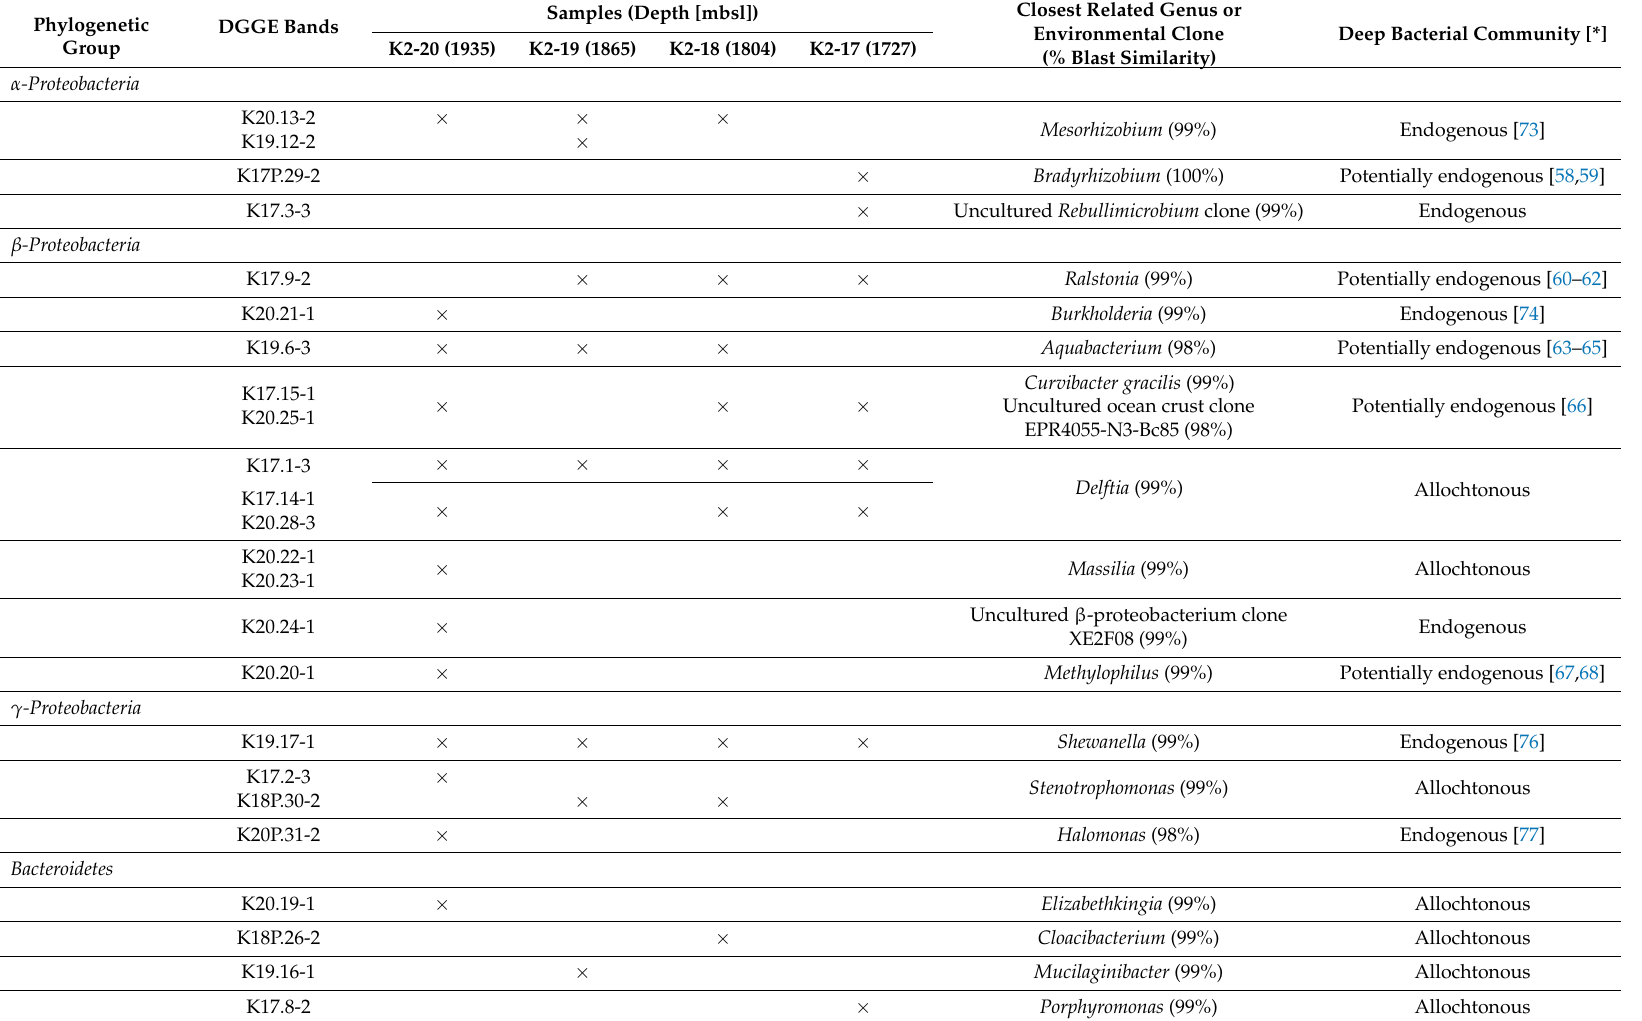
Table 4. Phylogenetic analysis of bacterial 16S rRNA genes detected in Triassic sandstones by